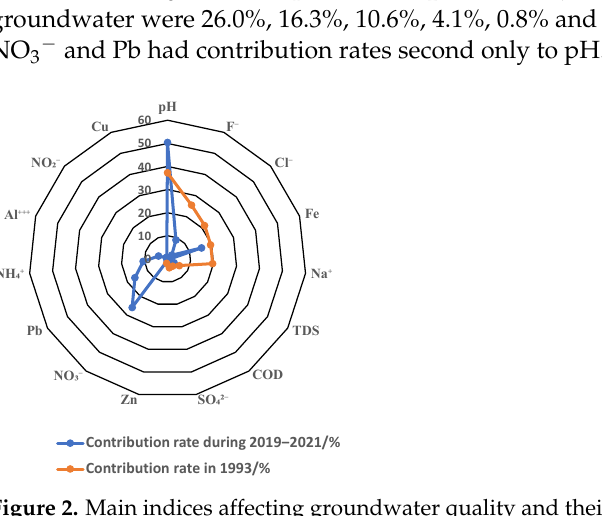
Figure 2. Main indices affecting groundwater quality and their contribution rates.